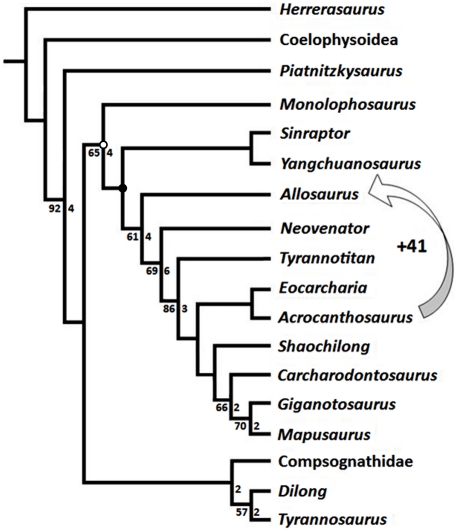
Single most parsimonious tree resulting from the phylogenetic
analysis.Primary analysis included 177 characters evaluated for 18 taxa (Length
 =  325 steps; CI  =  0.60; RI
 =  0.66; RCI  =  0.39).
Bootstrap values >50% are to the left of the nodes; Bremer
support values >1 are to the right. The open circle represents
Carnosauria; the closed circle represents Allosauroidea. The arrow shows
the number of steps needed to remove Acrocanthosaurus
from its current position within Carcharodontosauridae and place it as
the sister taxon to Allosaurus, a relationship proposed
by previous authors (Figure
33).